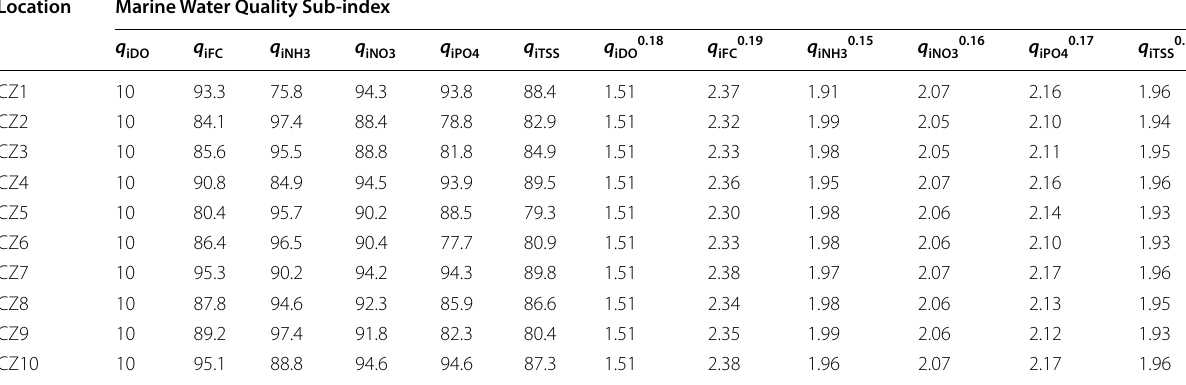
Table 7 Results of marine water quality index (MWQI) for the various locations